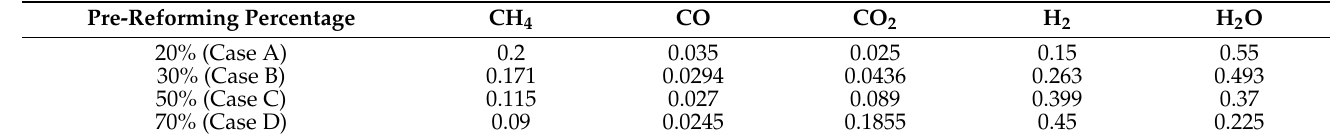
Table 7. The initial molar fractions of species with different pre-reforming percentage [4].